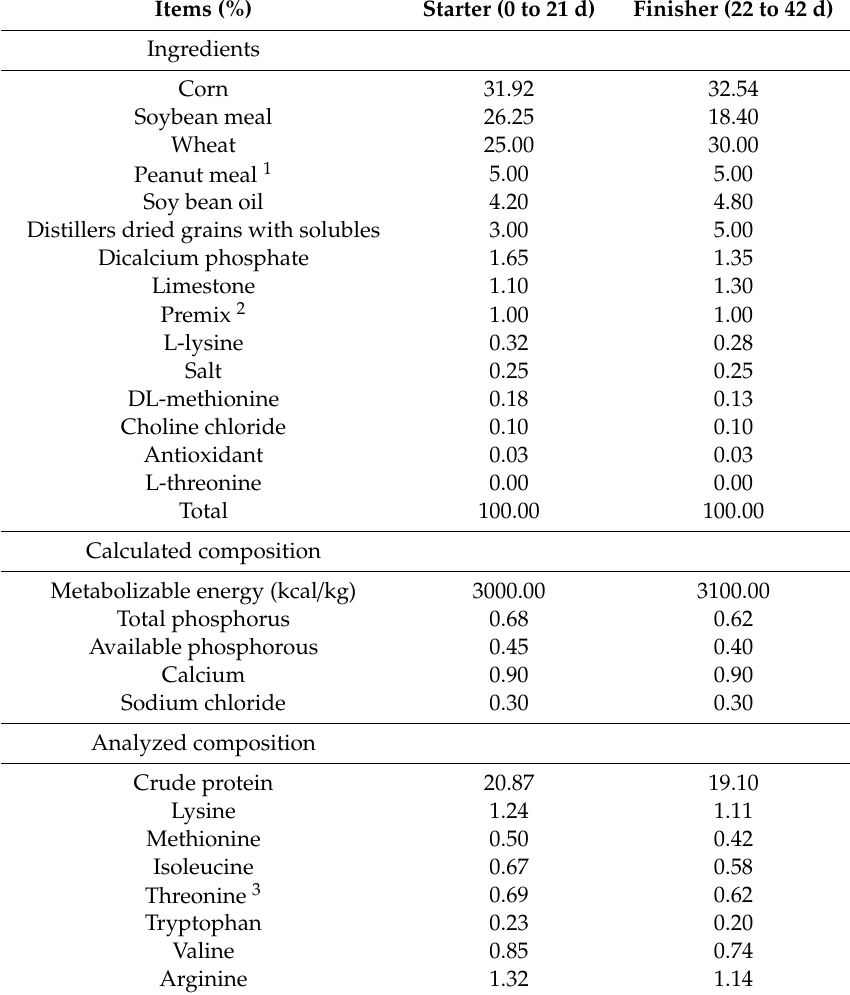
Table 1. Ingredients and nutrient composition of the basal diet (as-fed